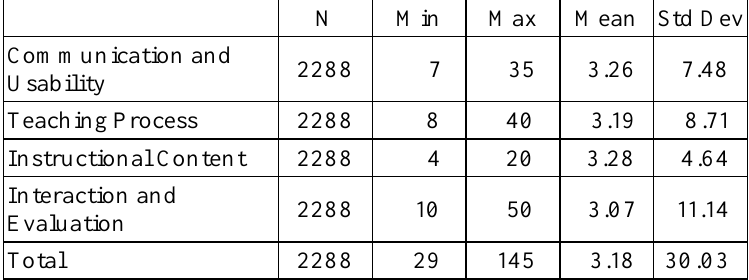
E-Satisfaction Scale Results N Min Max Mean Std